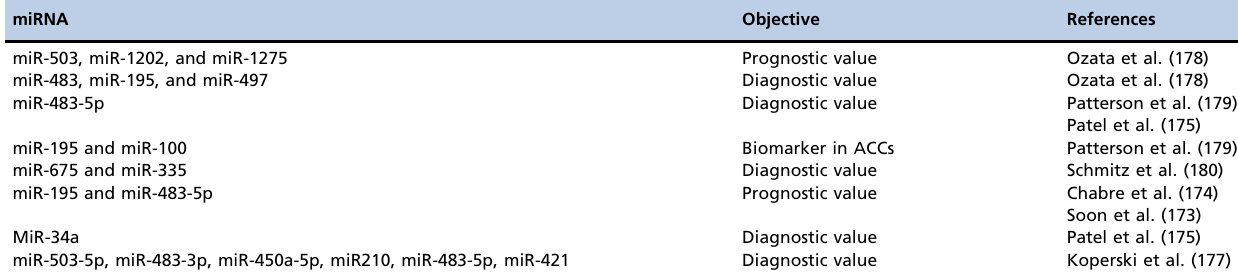
Table 3 - miRNA in